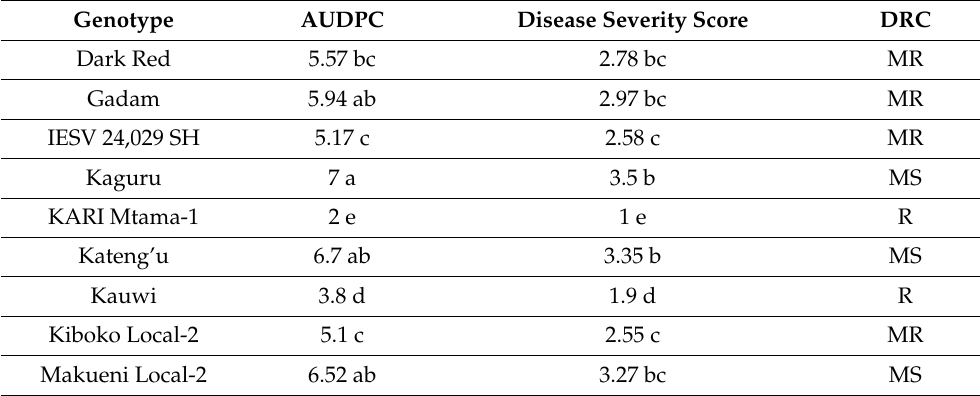
Table 5. Area under the disease progress curve (AUDPC), disease severity scores and disease reaction types in 14 sorghum genotypes following inoculation with Colletotrichum sublineolum (Isolate KT001-A) under greenhouse